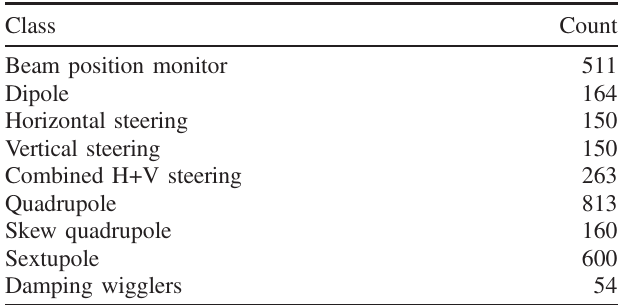
TABLE II. Summary of elements in the DTC04 lattice.